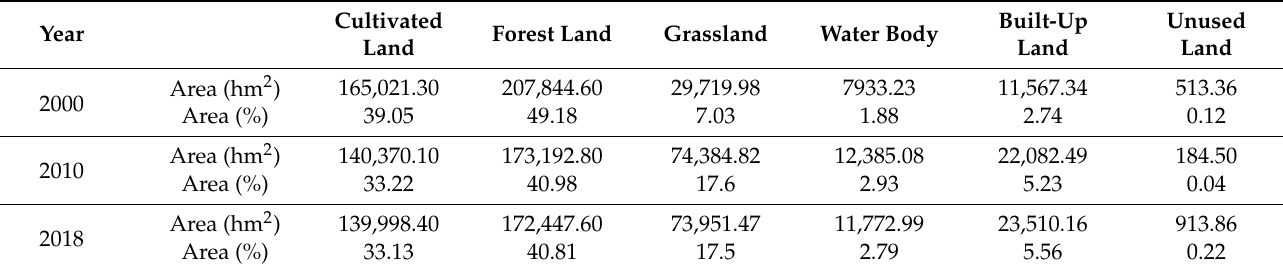
Table 1. Land use type area and proportion in 2000, 2010 and